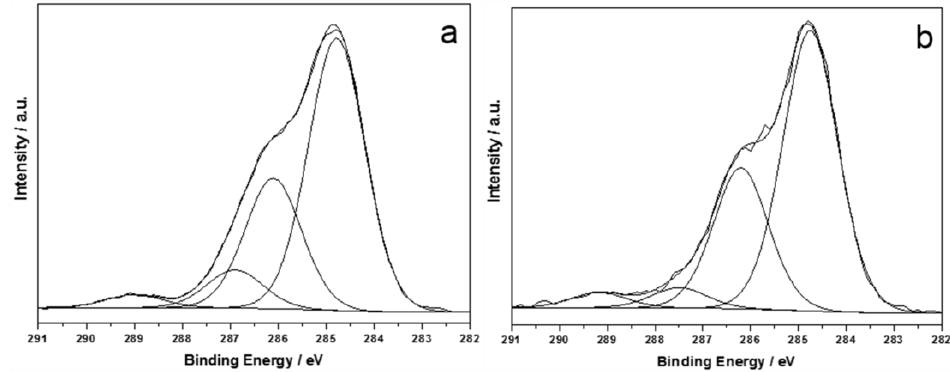
Figure 2. C1s X-ray photoelectron high-resolution region (XP-HRR) of pristine leather ( a ) and Ag-treated leather ( b ).